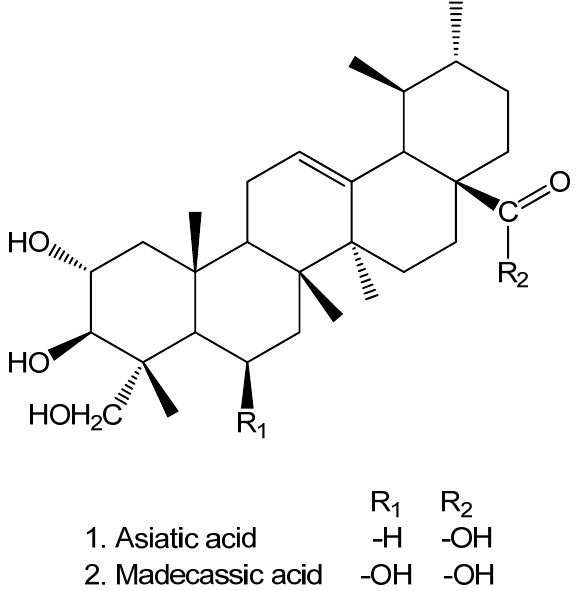
Figure 4. Molecular structures of asiatic acid and madecassic acid.